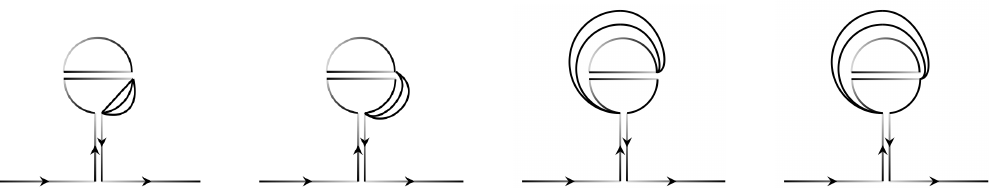
Figure 4: Additional O ( T / N ) mushroom diagrams that become possible once 5-pt interactions – corresponding to the second term in the Taylor series (123) – are in- cluded. Note that since the extra internal c τ (generically, Y ( 0 ) ( τ ) ) propagators con- nect two vertices through which the same neuron index already flows, they do not change the order of these diagrams relative to the 3-pt mushrooms in fig.